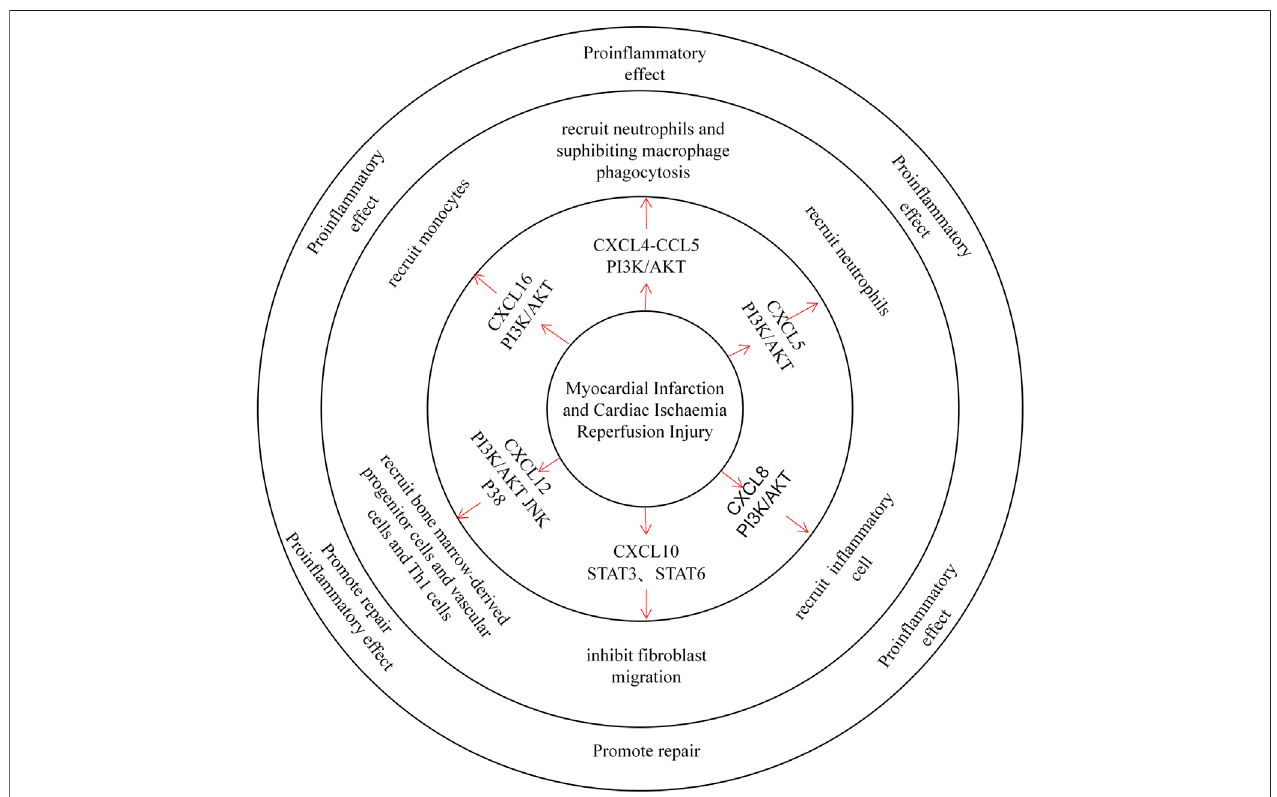
FIGURE 2 | CXC chemokines in the Myocardial Infarction and Cardiac Ischaemia Reperfusion Injury. CXCL4 recruited neutrophils in a mouse MI model and inhibited macrophage phagocytosis after MI, exacerbating tissue injury. CXCL5 recruits neutrophils and promotes in fl ammatory development. CXCL8 recruits in fl ammatory cells through the PI3K / AKT pathway and plays a pro-in fl ammatory role. CXCL10 can inhibit fi broblast migration and thus promote tissue repair. CXCL12 recruits both bone marrow-derived progenitors, vascular cells, and Th1 cells, playing both proin fl ammatory and repair roles. CXCL16 primarily recruits monocytes to promote in fl ammatory